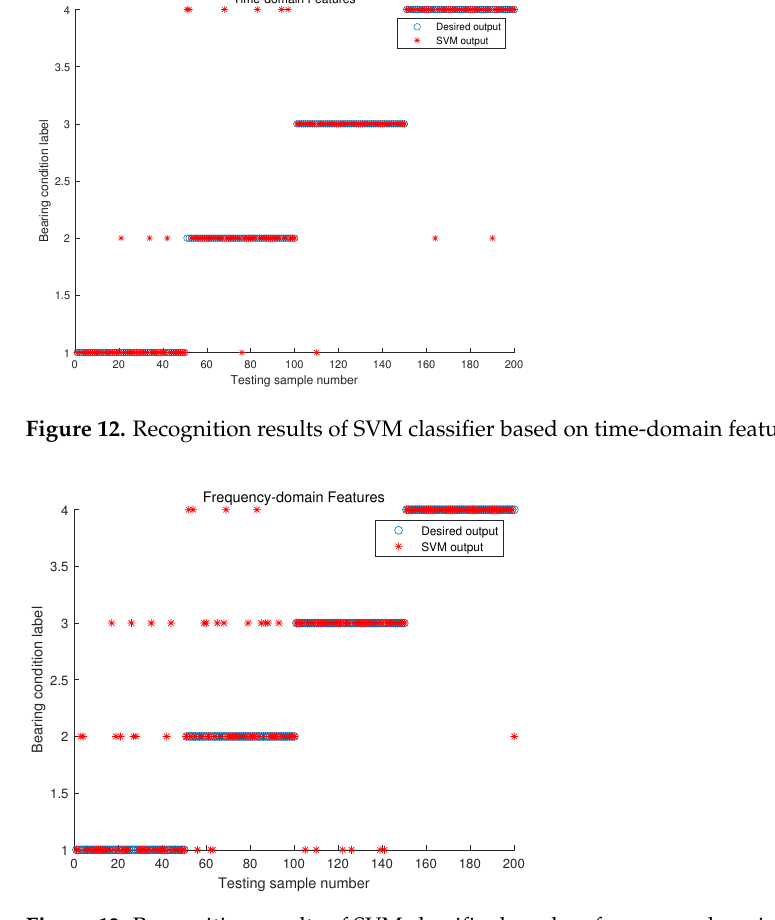
Figure 13. Recognition results of SVM classifier based on frequency-domain features.